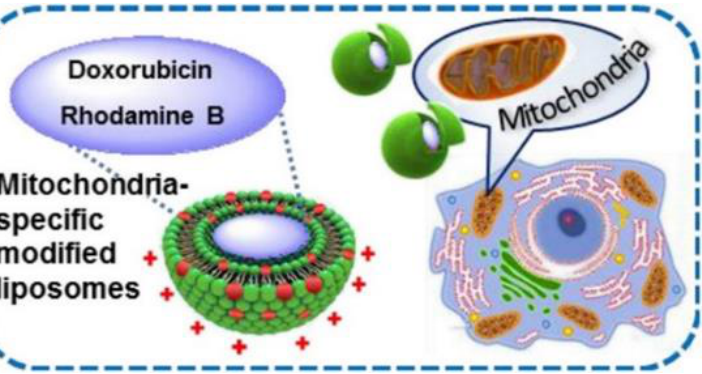
Figure 3. Schematic representation of mitochondria-specific modified liposomes. Reprinted with permission from [47]. Copyright 2021